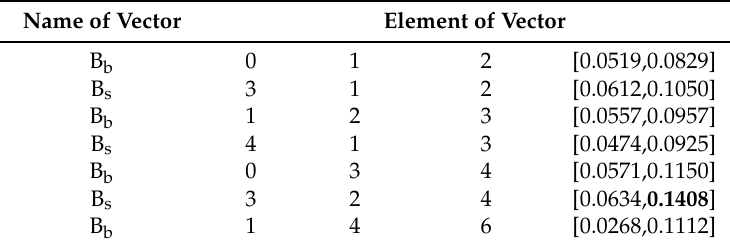
Table 8. Identification template 1 for water class.